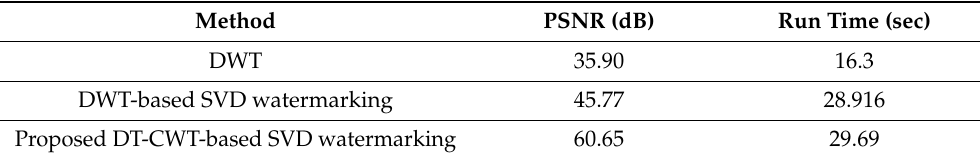
Table 7. Comparison between the proposed watermarking method and the traditional methods without attacks using LSB method for mobile video.